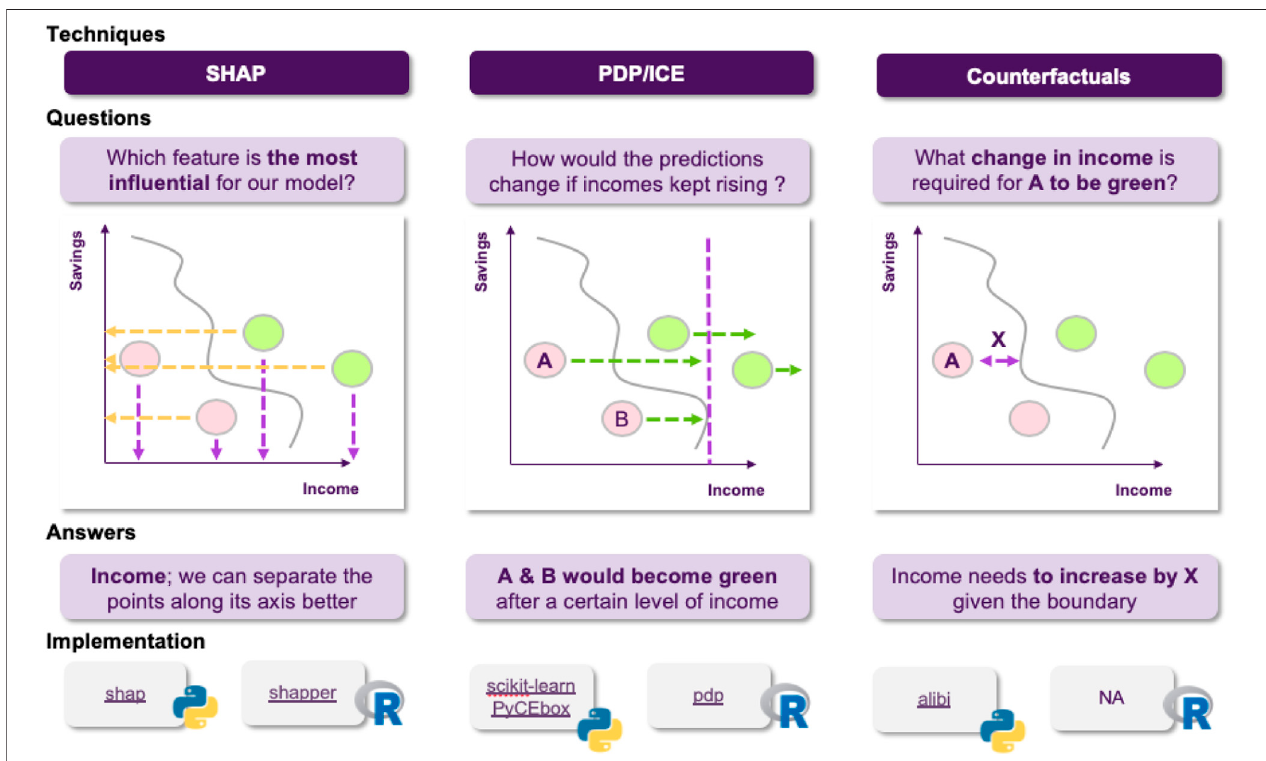
FIGURE 15 | Using SHAP, PDF and counterfactuals, visualized in terms of